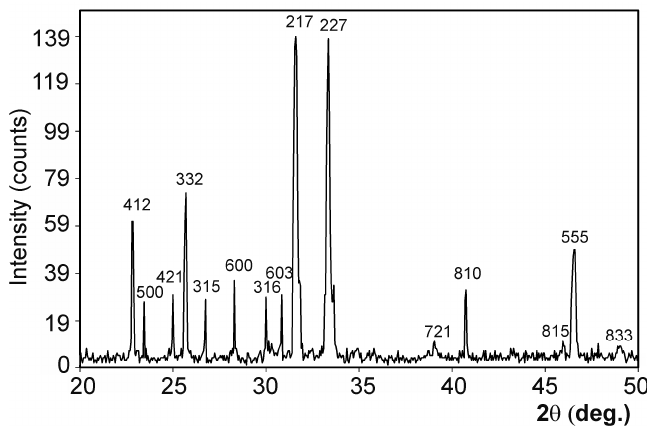
Figure 1. XRD pattern of the Nurse’s A powders.